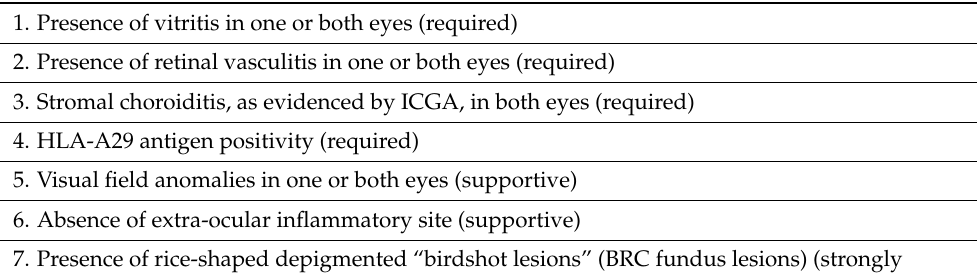
Table 5. Global diagnostic criteria for HLA-A29 birdshot retinochoroiditis